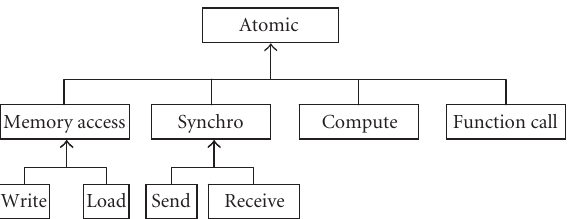
Figure 1: Global flow.